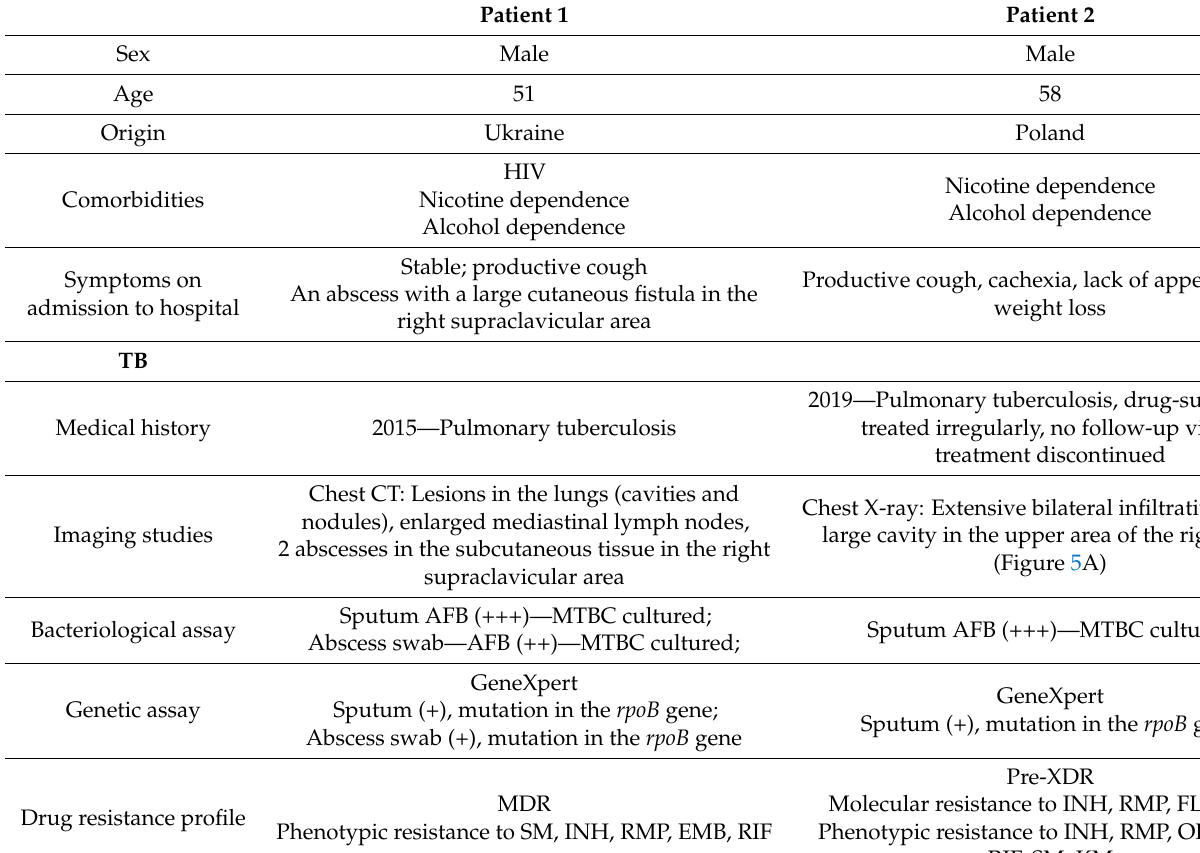
Table 1. Microbiological and clinical characteristics of the reported